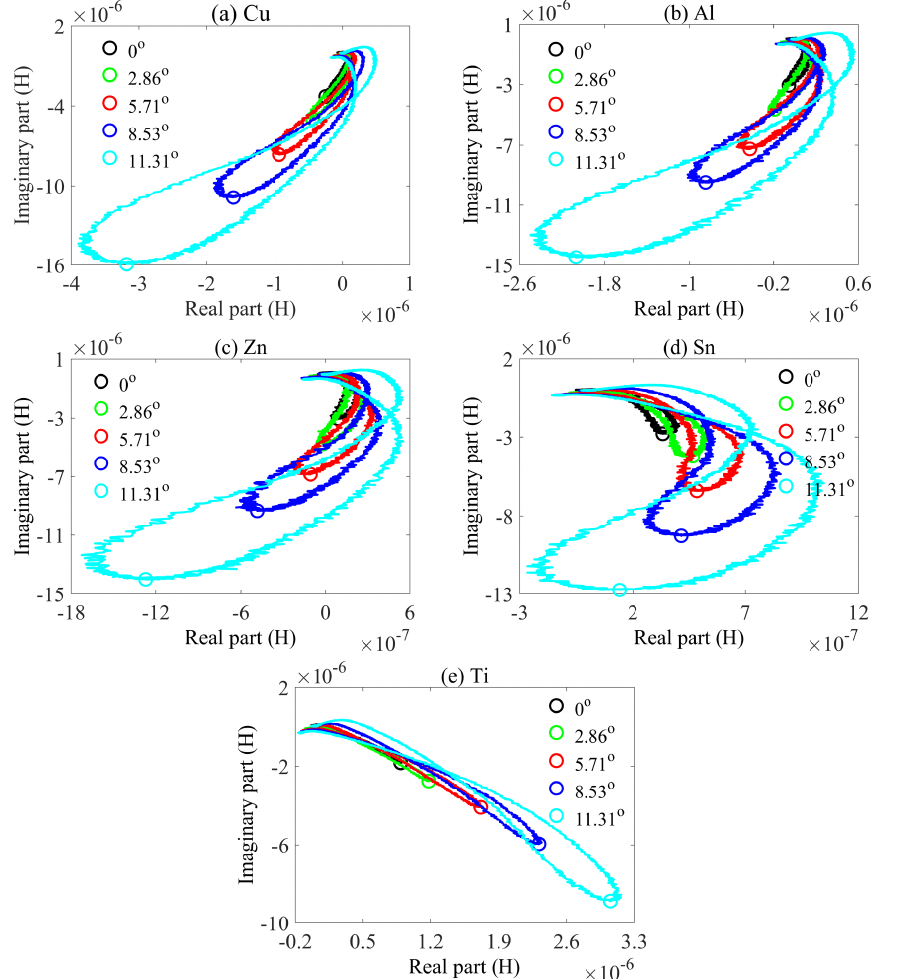
Figure 4. Measured mutual inductances in the form of real part and imaginary part for tilting samples. ( a ) Cu. ( b ) Al. ( c ) Zn. ( d ) Sn. ( e ) Ti. black line denotes 0 ◦ , green line denotes 2.86 ◦ , red line denotes 5.71 ◦ , blue line denotes 8.53 ◦ , cyan line denotes 11.31 ◦ . Circles are the points corresponding to characteristic